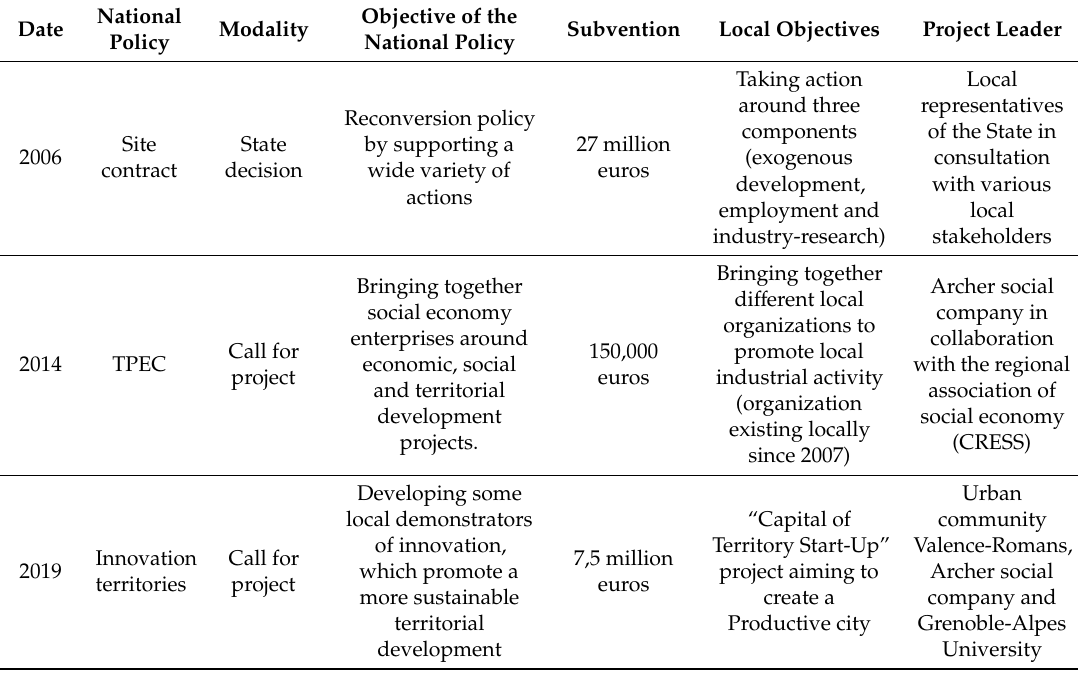
Table 2. Characteristics of three important policies for Romans-sur-Is è re (source: